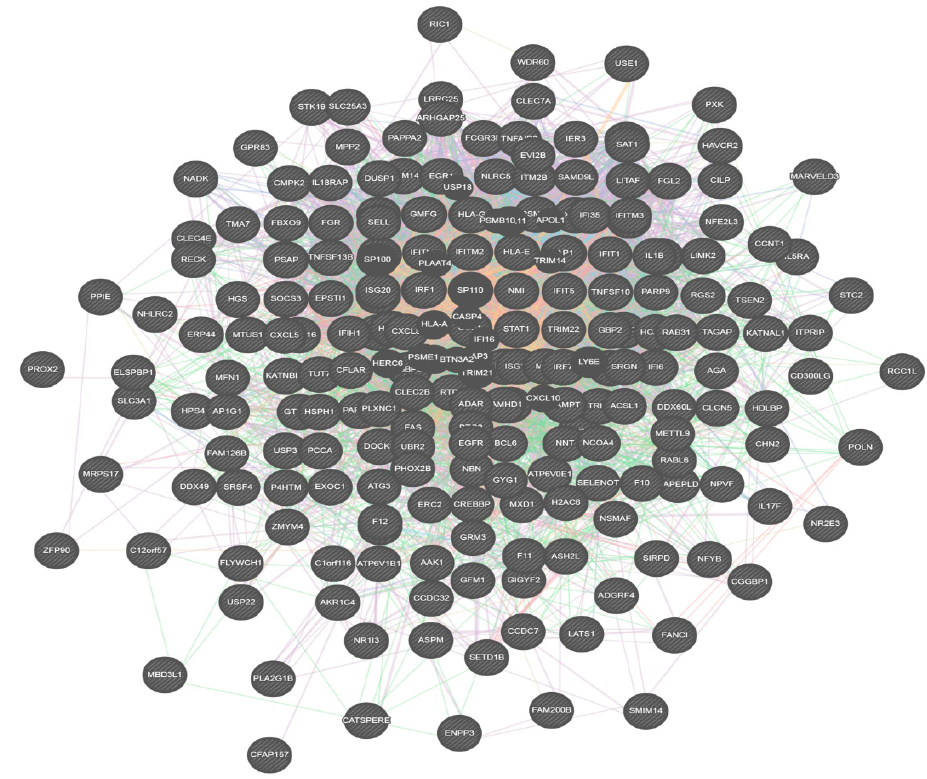
Figure 1. Integrated network of periodontitis and rheumatoid arthritis.